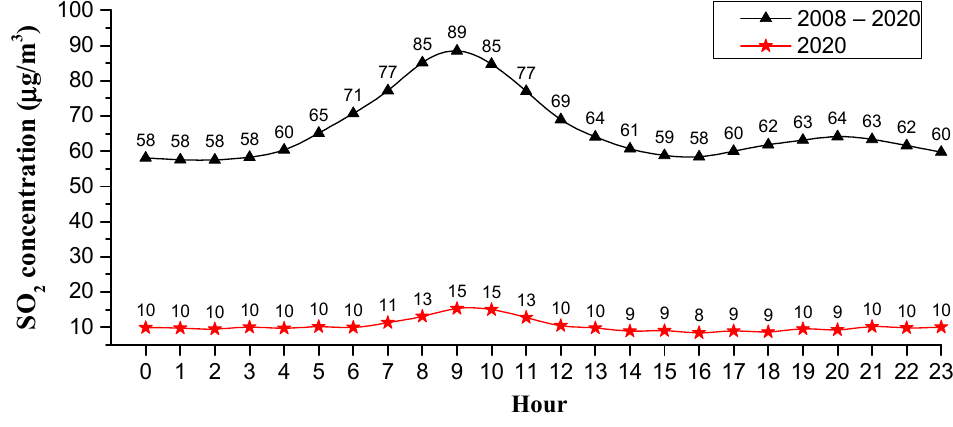
Figure 8. Hourly average concentration of SO 2 from 2008 to 2020.